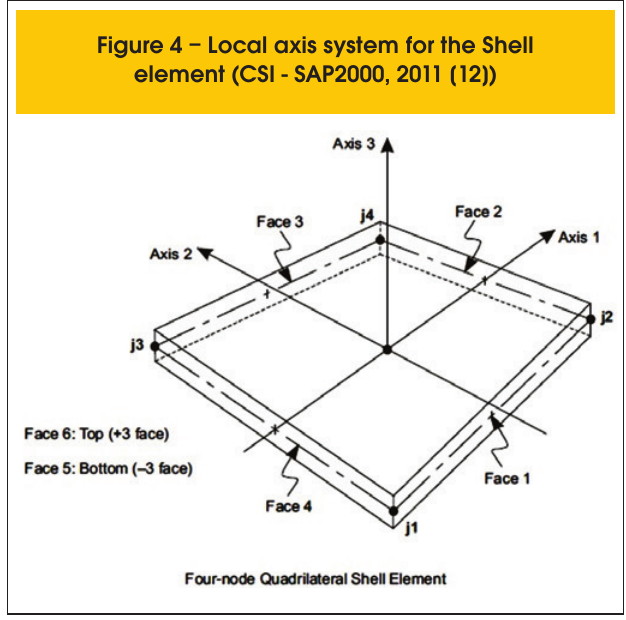
Figure 4 – Local axis system for the Shell element (CSI - SAP2000, 2011 [12])